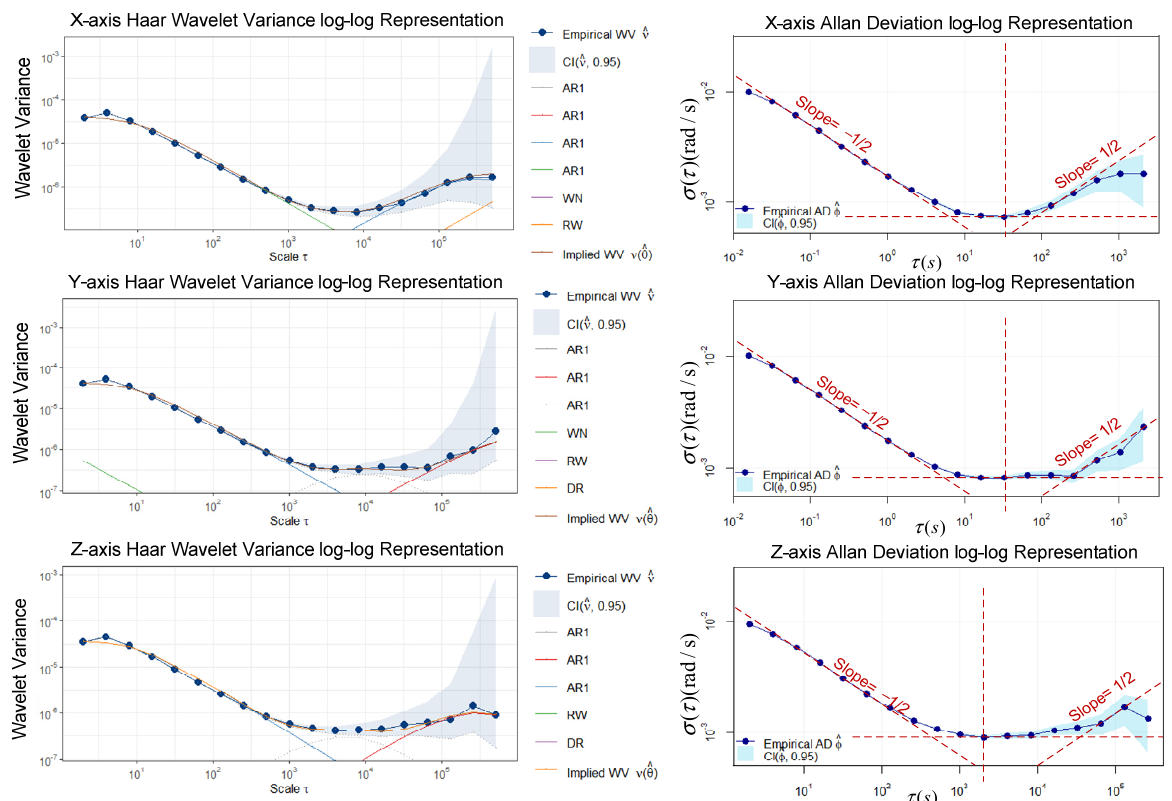
Figure 5. GMWM log–log plot of the three-axis gyroscope ( left column ) and AV log–log plot of the three-axis gyroscope ( right column ). The red dashed lines are auxiliary lines to help identify linear regions.